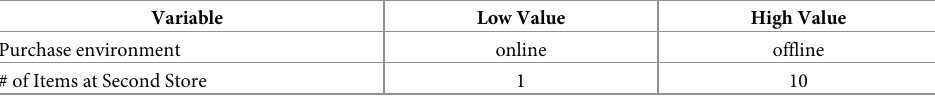
Table 12. Anchor values for each cart presentation (Study